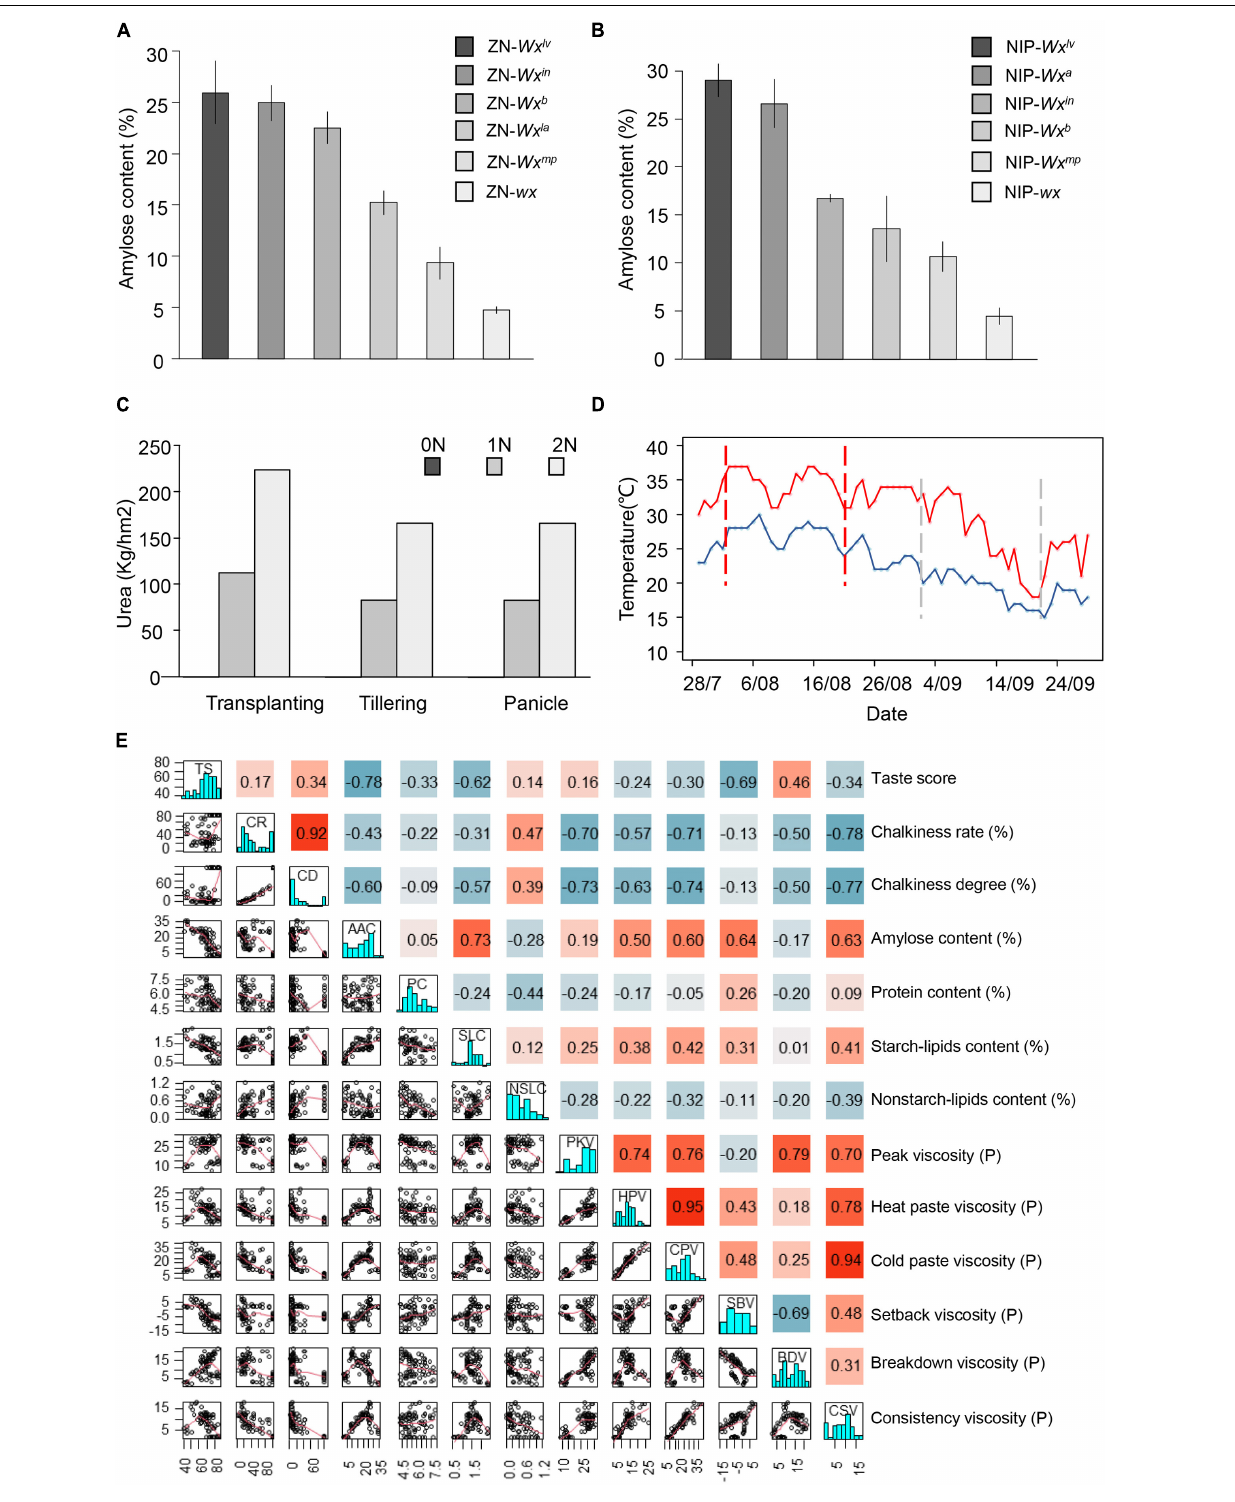
Frontiers in Plant Science |